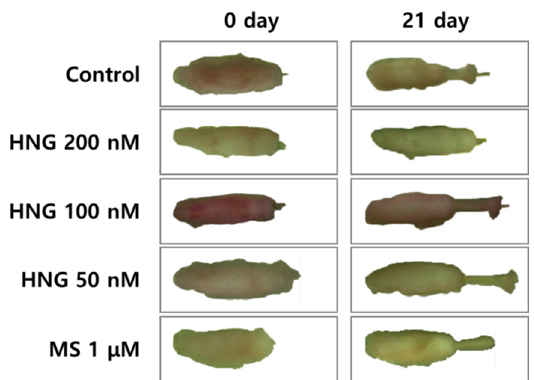
Figure A1. Photographs of the cultured rat vibrissa follicles acquired using a stereomicroscope. Rat vibrissa follicles were isolated and cultured with the indicated concentrations of HNG or MS for 21 days.